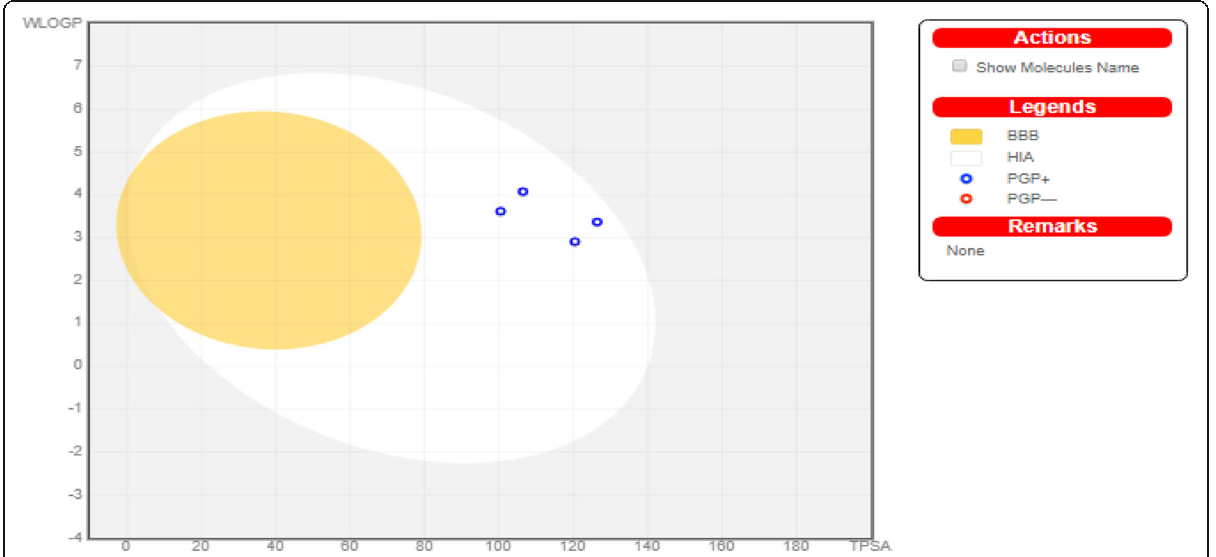
Fig. 6 Boiled-egg Plot of the lead compounds generated from SWISS